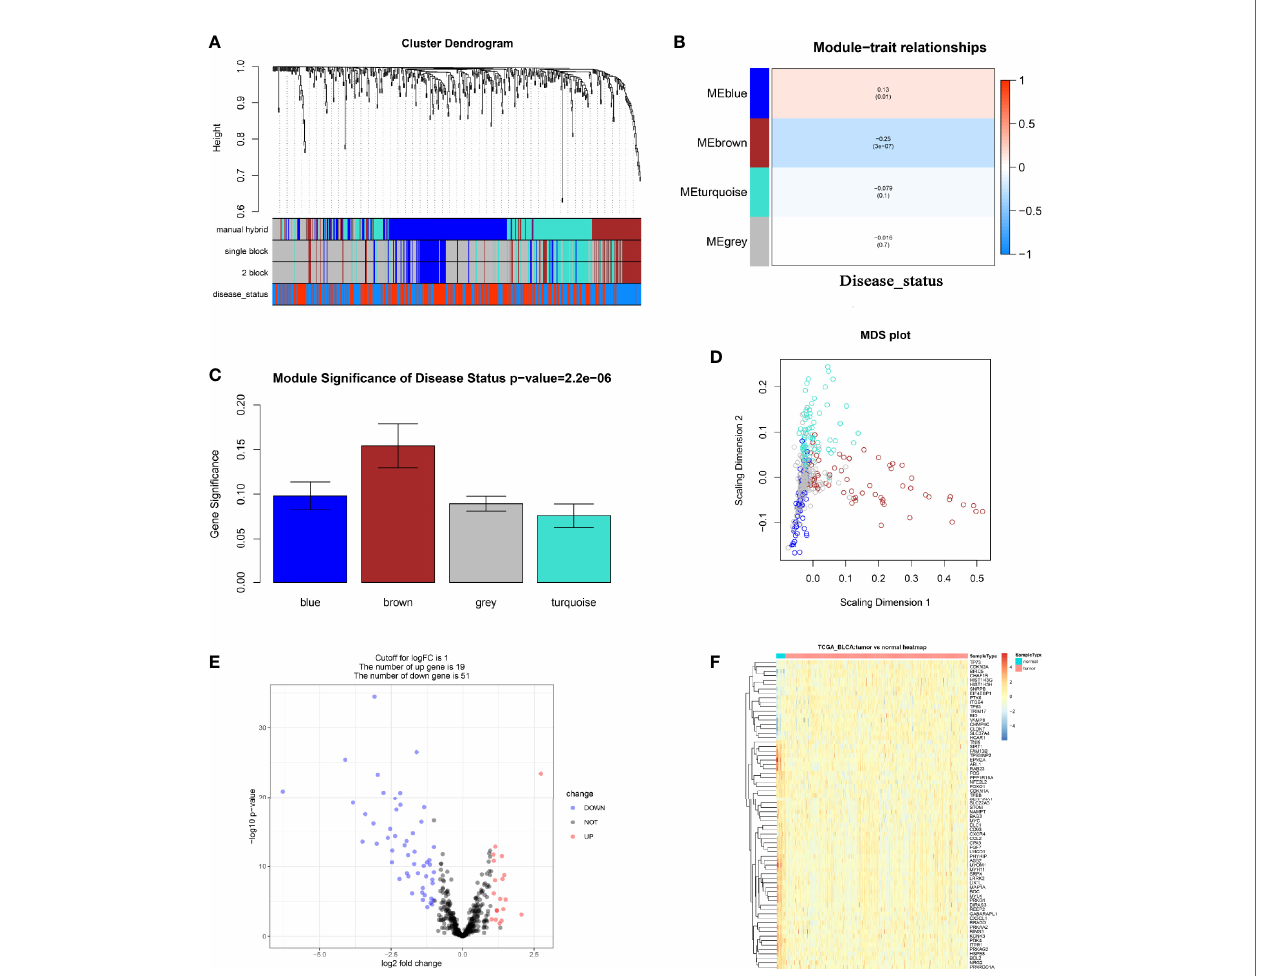
FIGURE 1 | Relevant module associated with clinical information identi fi cation and differentially expressed ARGs identi fi cation. (A) Dendrogram of all differentially expressed genes clustered based on a dissimilarity measure (1-TOM). Manual hybrid: the manual (interactive) branch cutting approach; single block: the automatic single block analysis; 2 block: the 2 block analysis; disease status: the trait interested us most (BLCAs or Normal tissues). (B) Heatmap of the correlation between module eigengenes and different clinical information of BLCA (disease status). (C) Distribution of average gene signi fi cance and errors in the modules associated with disease status of BLCA. (D) Classical MDS plot whose input is the TOM dissimilarity. Each dot (gene) is colored by the module assignment. (E) Volcano plot visualizing differentially expressed ARGs in TCGA-BLCA data. (F) Heatmap of differentially expressed ARGs between tumor samples vs normal samples (P < 0.05, fold change > 1,